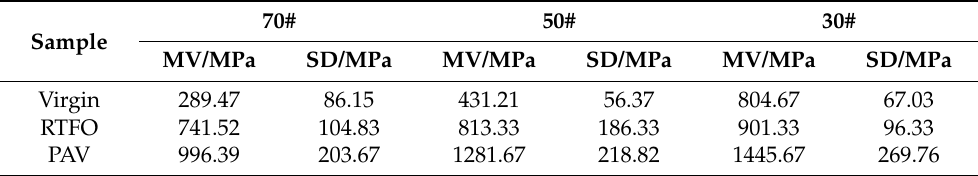
Table 3. Mean value (MV) and standard deviation (SD) of the DMT modulus.